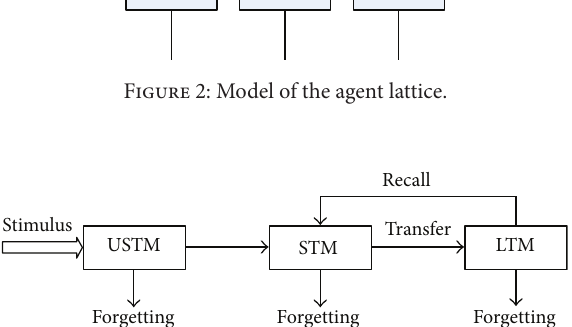
Figure 3: Three-stage human brain memory model.